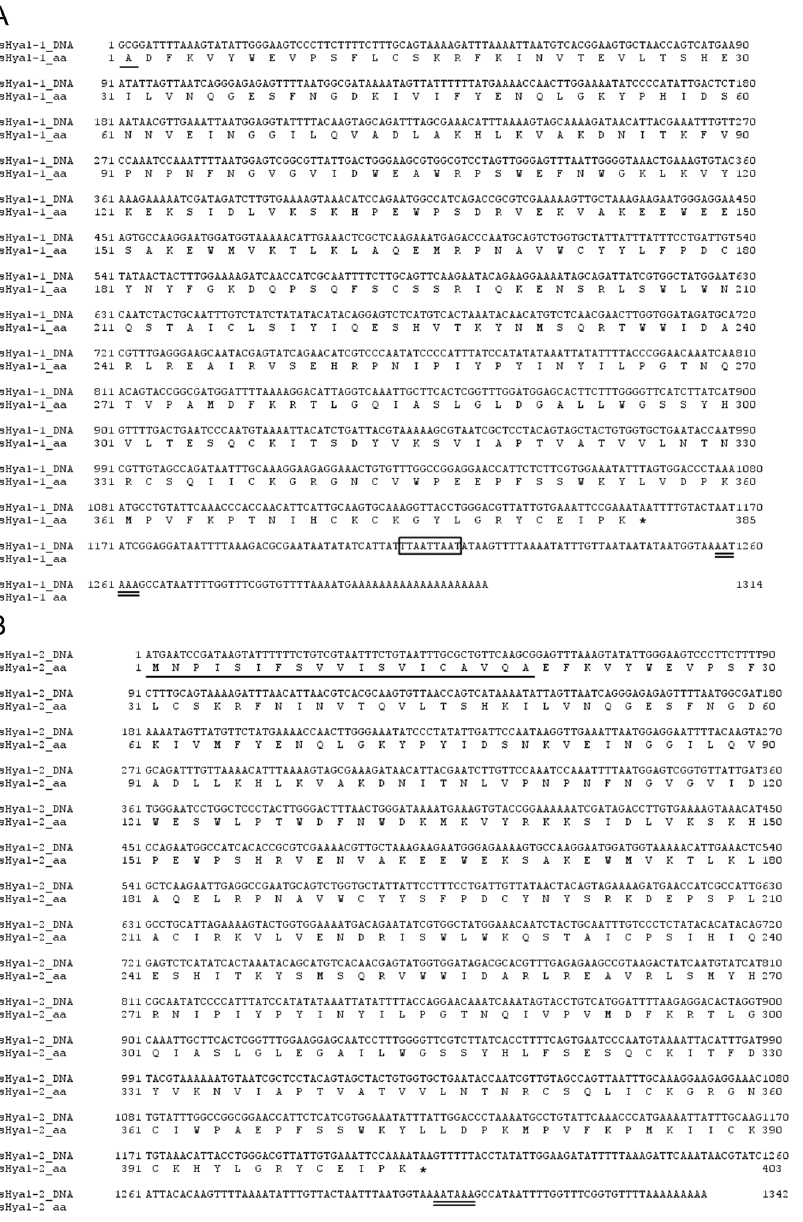
PLOS Neglected Tropical Diseases |